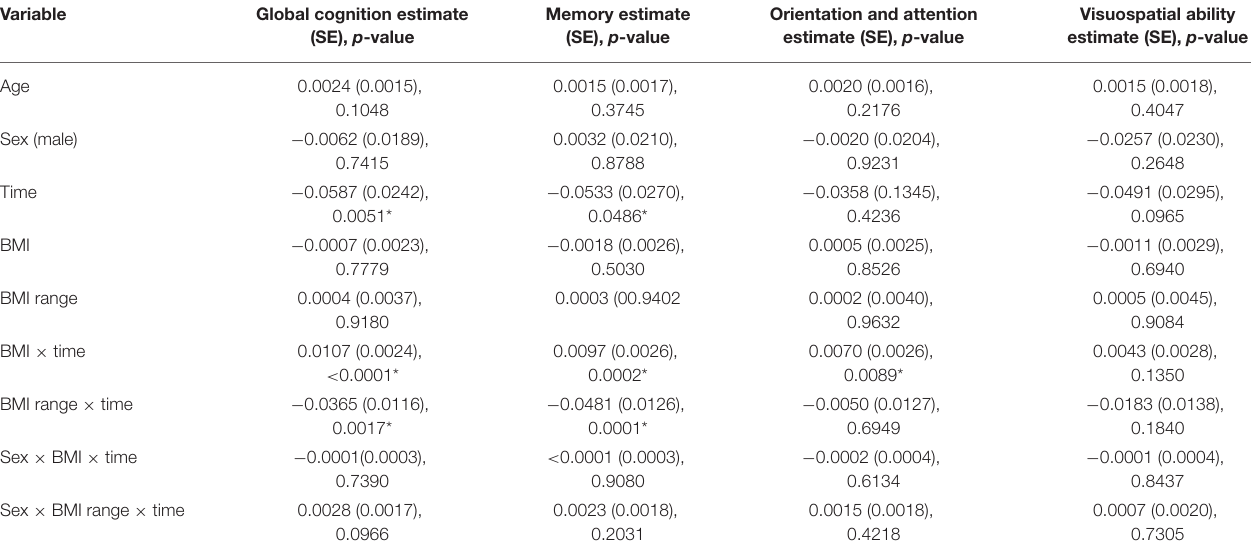
TABLE 2 | The association between body mass index (BMI), BMI range, and decline among global cognition and cognitive subdomains (SD per year). Variable Global cognition estimate Memory estimate (SE), p -value (SE), p -value